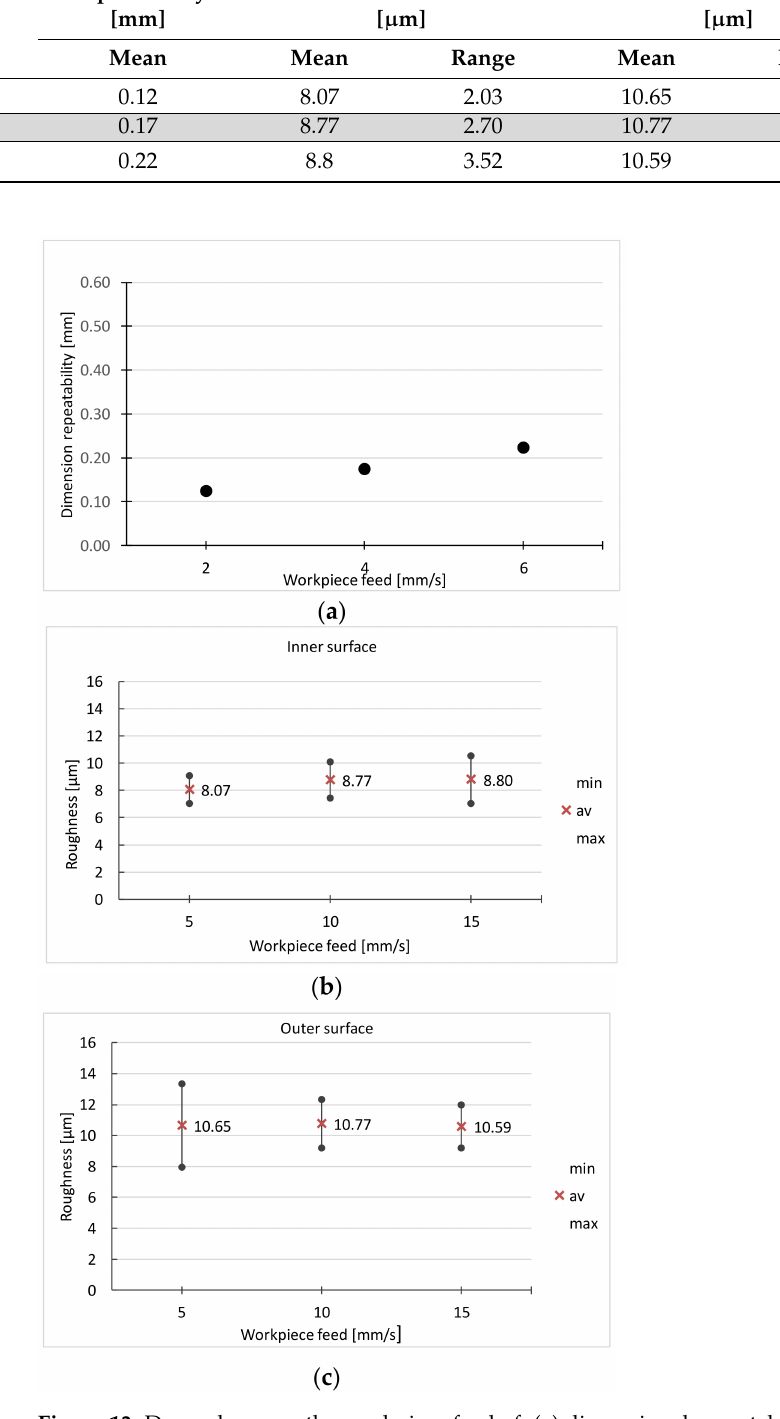
Figure 13. Dependence on the workpiece feed of: ( a ) dimensional repeatability, ( b , c ) surface rough- ness ( F n = 10 N, v s = 26